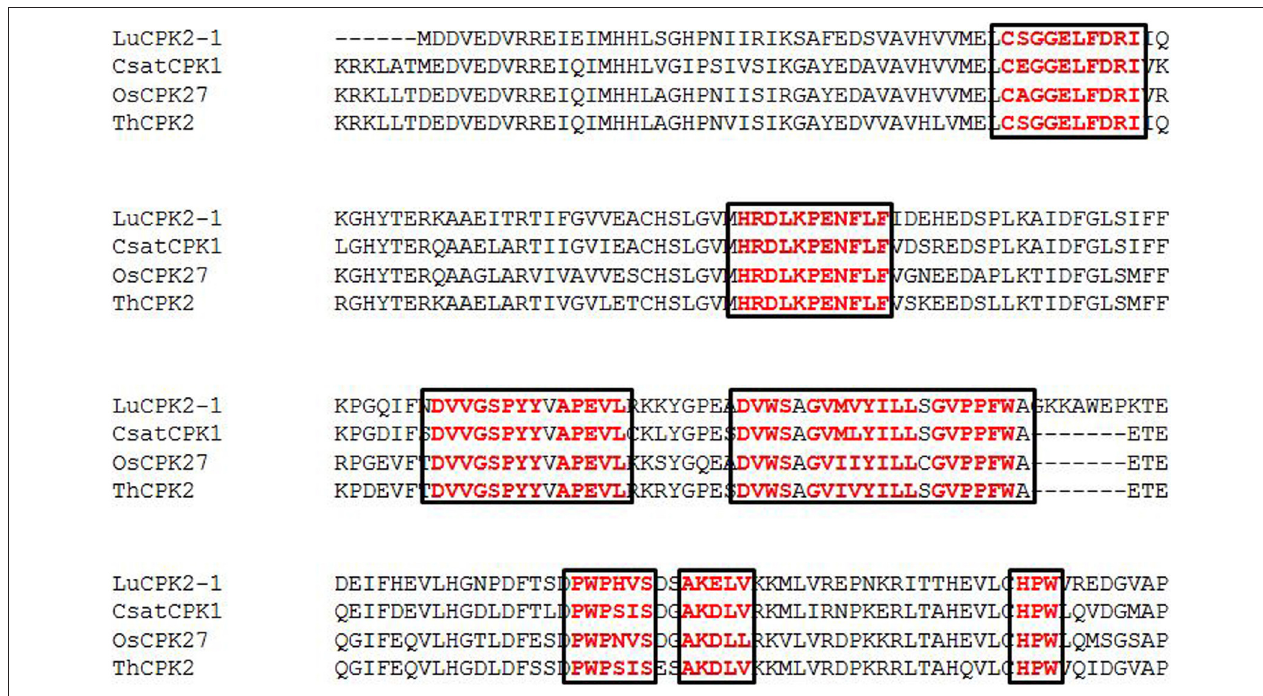
FIGURE 2 | Presence of conserved domains in the kinase domain of plant calcium-dependent protein kinases (CPKs) (red). The major conserved domains are C-S-G-G-E-L-F-D-R-I, H-R-D-L-K-P-E-N-F-L-F, D-V-V-G-S-P-Y-Y, A-P-E-V-L, D-V-W-S, G-V-M-V-Y-I-L-L, G-V-P-P-F-W, P-W-P-H-V-S, A-K-E-L-V, and H-P-W. The complete details describing the conserved domains of CPKs are provided in the Supplementary